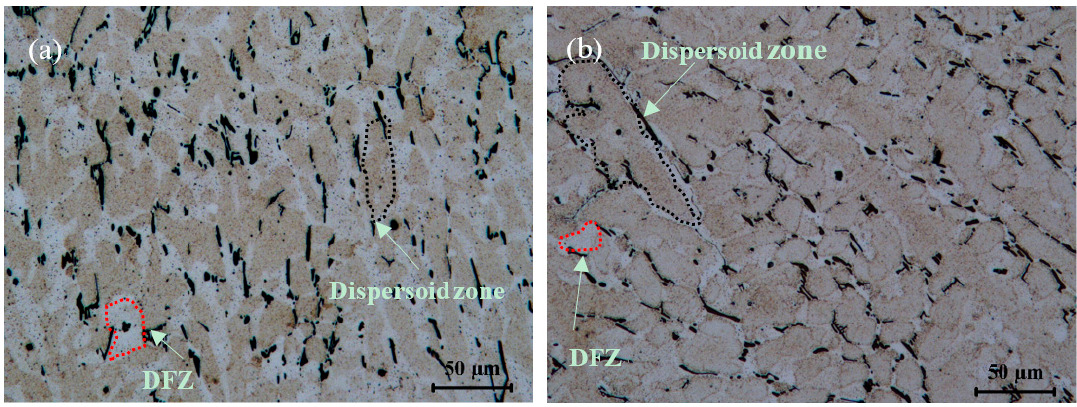
Figure 4. Optical images of ( a ) DU0 alloy and ( b ) DU120 alloy after heat-treatment at 425 °C for 6 h.